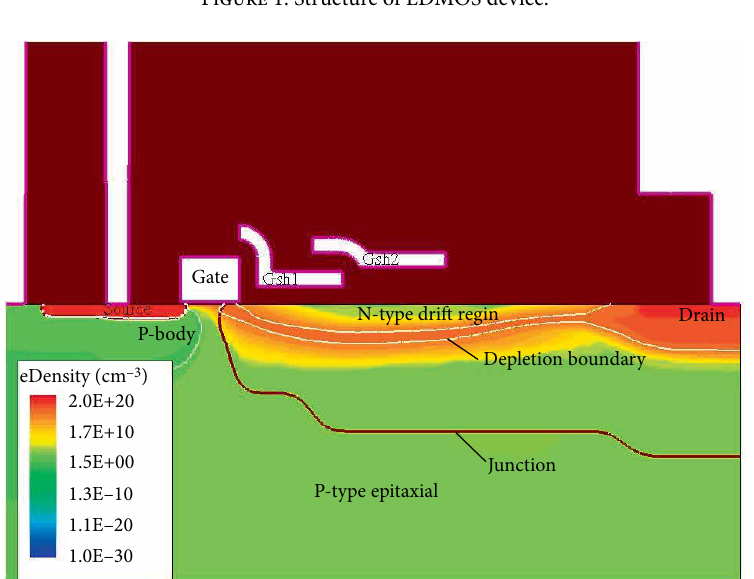
Figure 1: Structure of LDMOS device.